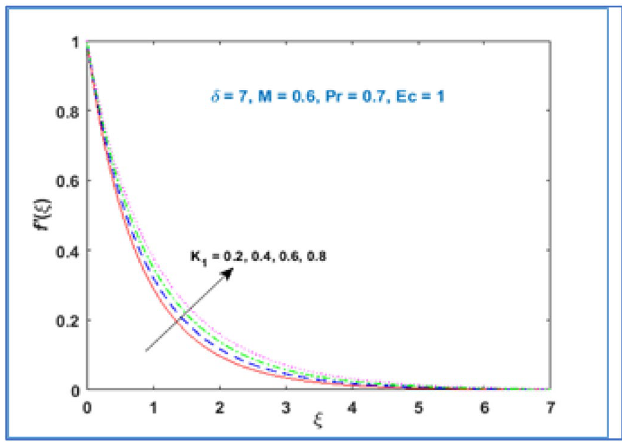
Figure 2. f ′ (ξ) versus K 1 .